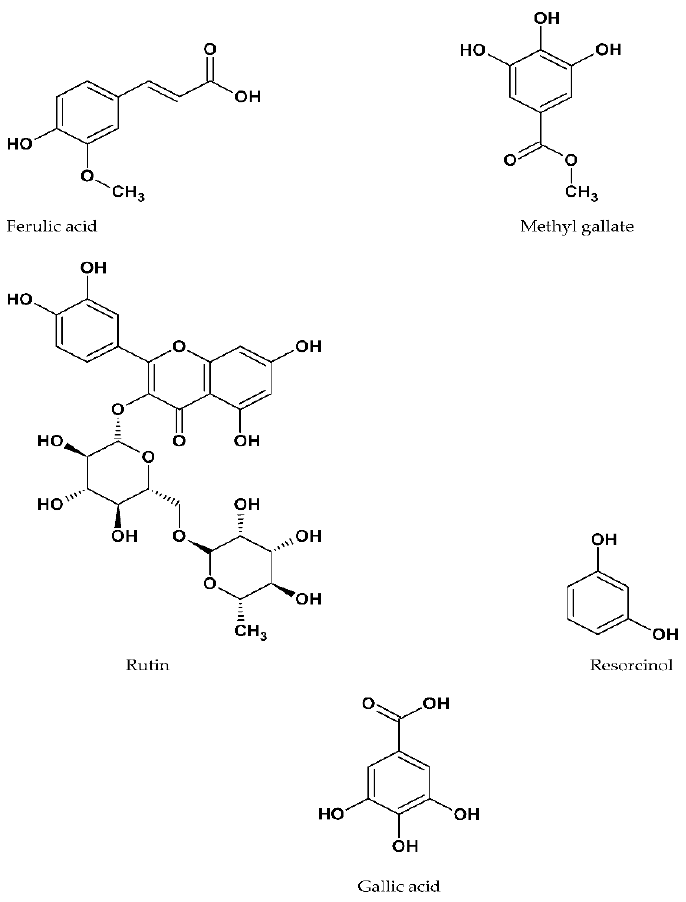
Figure 4. Chemical structures of compounds identified using HPLC of the polyphenol-rich fraction of A. europaea .